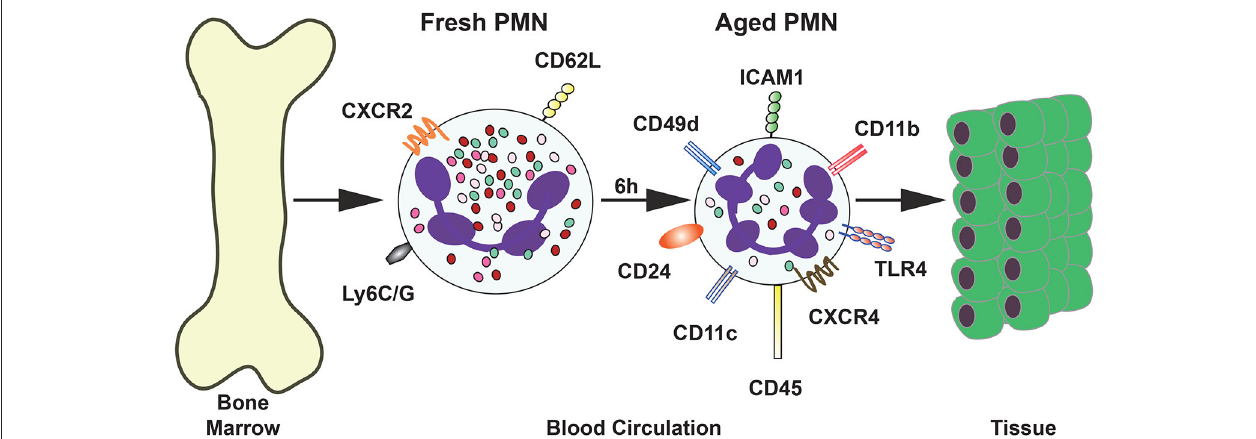
FIGURE 3 | Phenotype of aged neutrophils. Upon release from the bone marrow, a “fresh” neutrophil (PMN) express the surface molecules CD62L and CXCR4. After several (4–6h) hours in the circulation neutrophils change the expression of many surface molecules. The new phenotype is described as “aged” neutrophils. These aged neutrophils are then cleared from the blood by migration into tissues or by returning to the bone